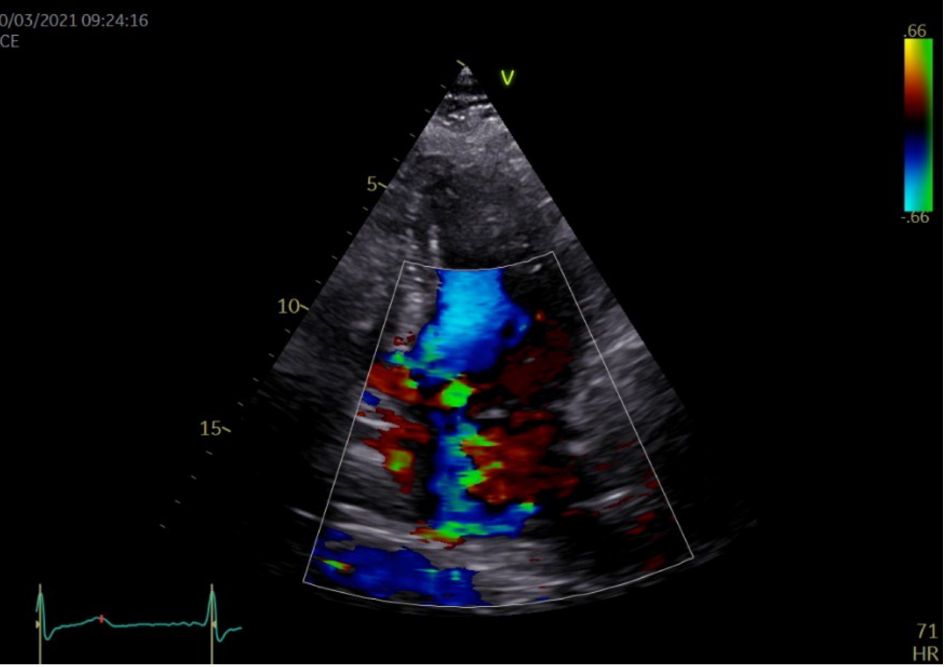
Figure 2. Transthoracic bidimensional echocardiography, four chamber view with color Doppler on the mitral valve: severe mitral valve regurgitation, with a central slightly posterolateral deviated jet. The regurgitant jet enters the pulmonary